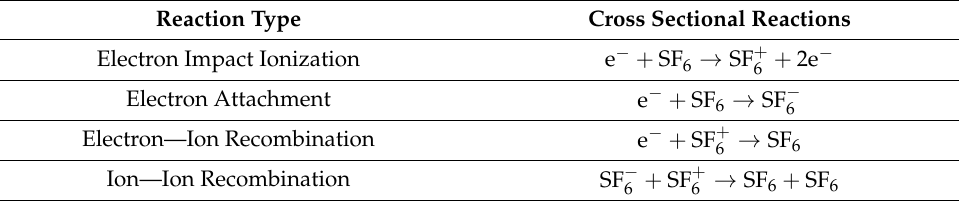
Table A1. Cross Sectional